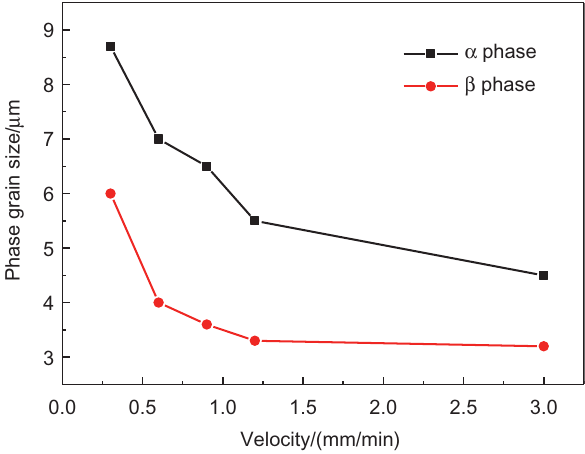
Figure 8: The phase grain sizes of specimen at various deformed